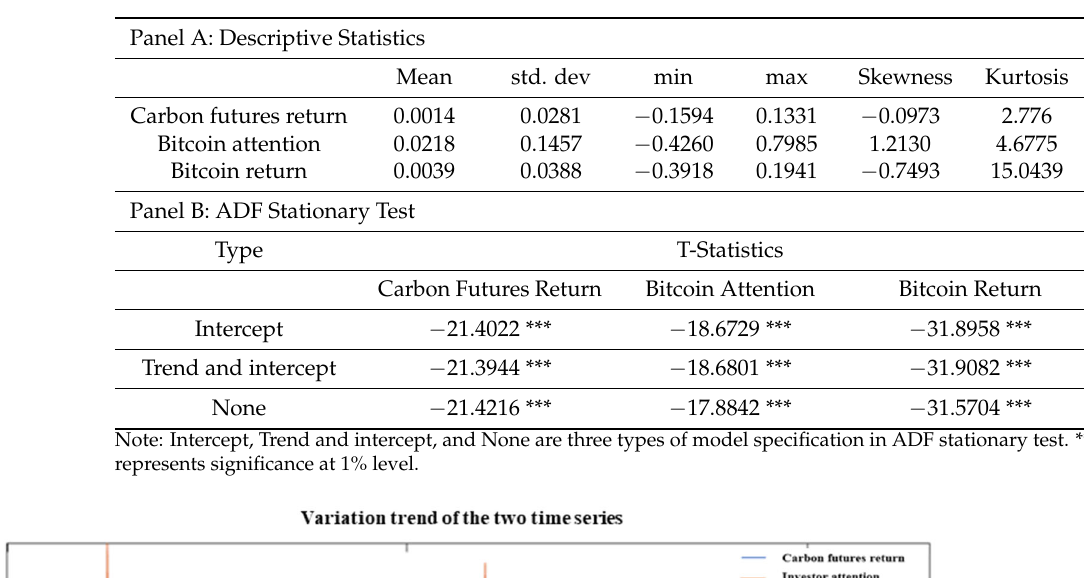
Figure 2. Price trend of Bitcoin. Note: The X-axis refers to the time while the Y-axis represents the price of Bitcoin per unit. Table 1. Descriptive statistics and the ADF stationary test of the interested time series.